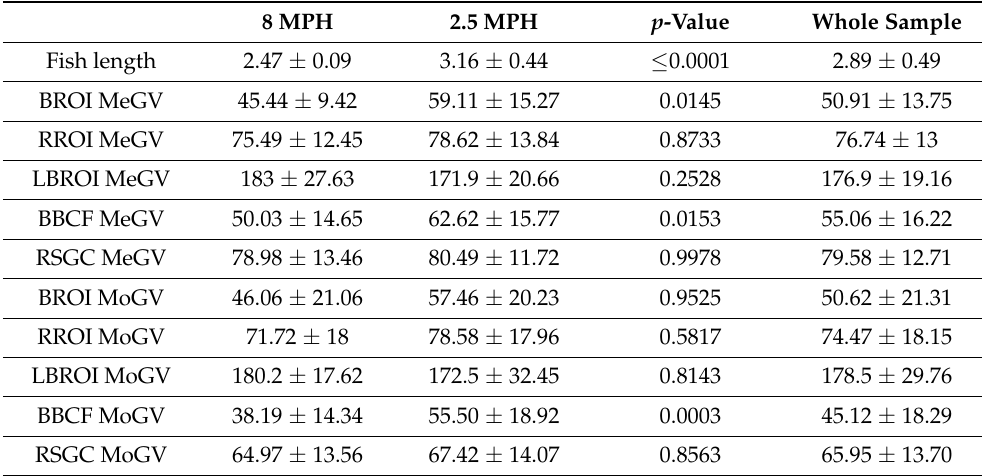
Table 1. Numerical measurement data and the MoGVs for the two sets of zones in the entire sample. The value ( p < 0.05) from unpaired t -test with Welch’s correction.